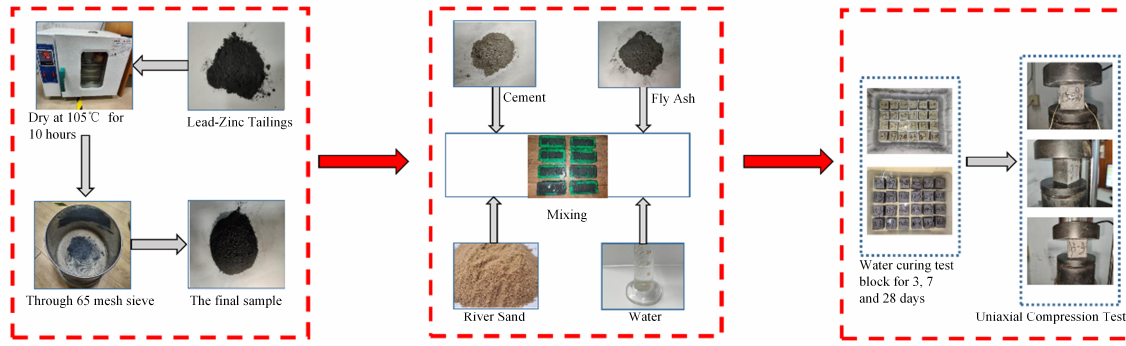
Figure 4. Test procedures.